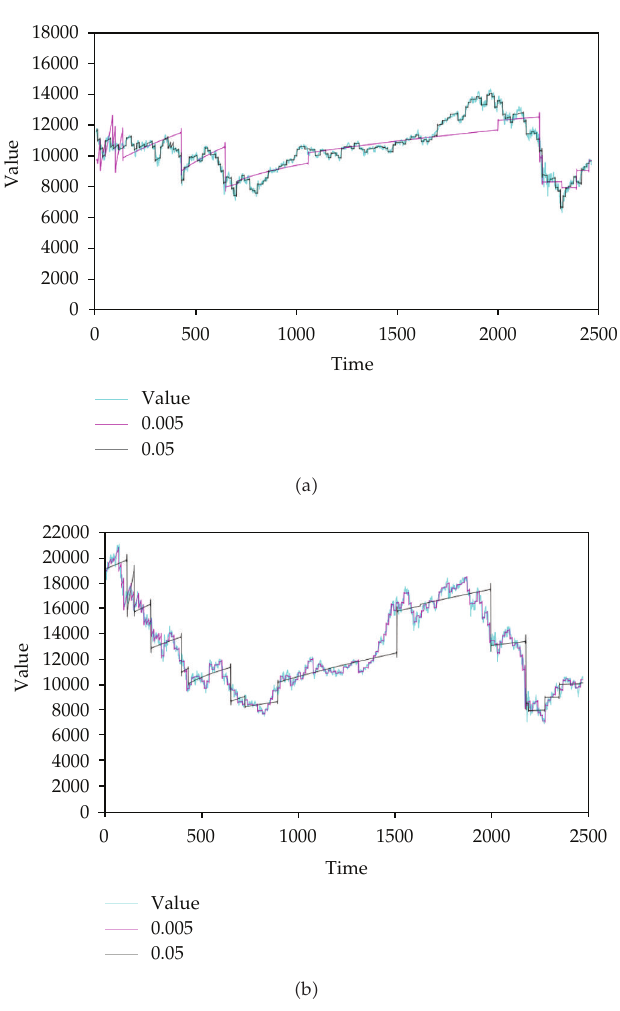
Figure 4: The temporal evolution and t PL trendline for the the Dow Jones x 2 (cid:2) k (cid:3) (cid:2) a (cid:3) and Nikkei x 6 (cid:2) k (cid:3) (cid:2) b (cid:3) indices from Jan. 2000 to Dec. 2009 with ε (cid:8) { 0 . 005 , 0 . 05 }